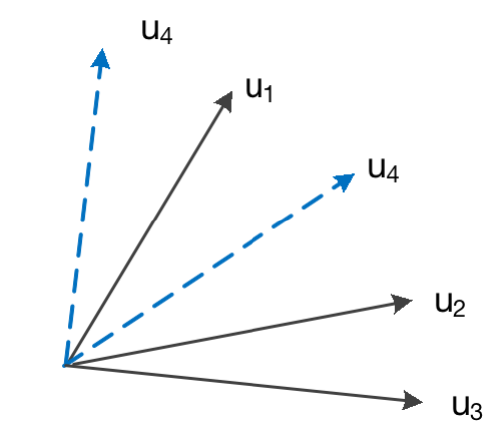
Figure 1. Defects in matrix